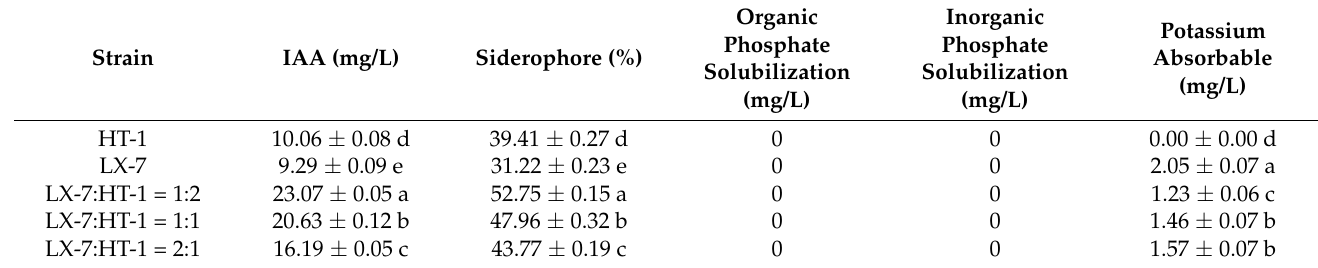
Table 1. In Vitro-Promoting Traits of HT-1 and LX-7 strains.